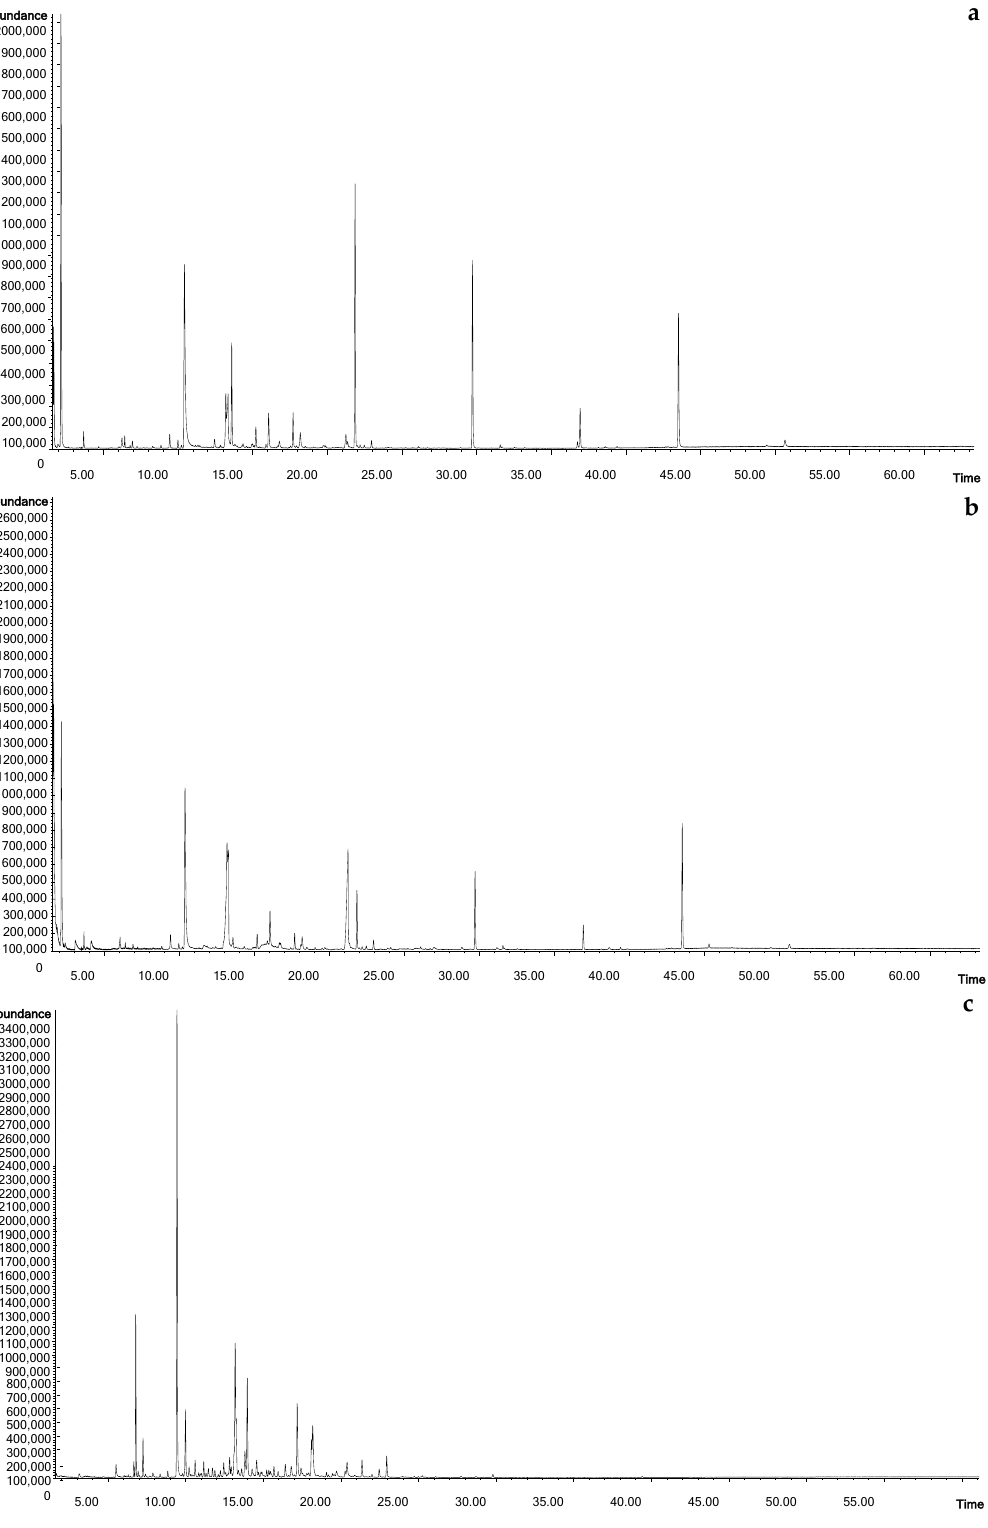
Figure 2. Comparison of the representative HS-SPME profiles of linden honey ( a ), not boiled mead ( b ) and boiled mead ( c ).